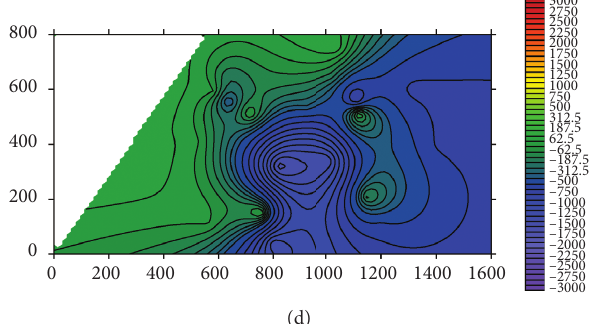
Figure 15: Second loading stage stable strain cloud map. (a) Model loading diagram. (b) Model loading variation diagram. (c) X-directional strain cloud map. (d) Y-directional strain cloud map.